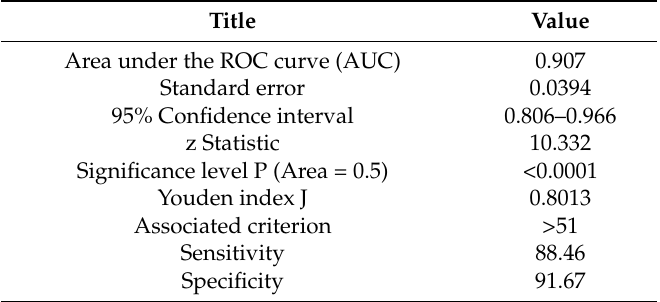
Area under the ROC curve